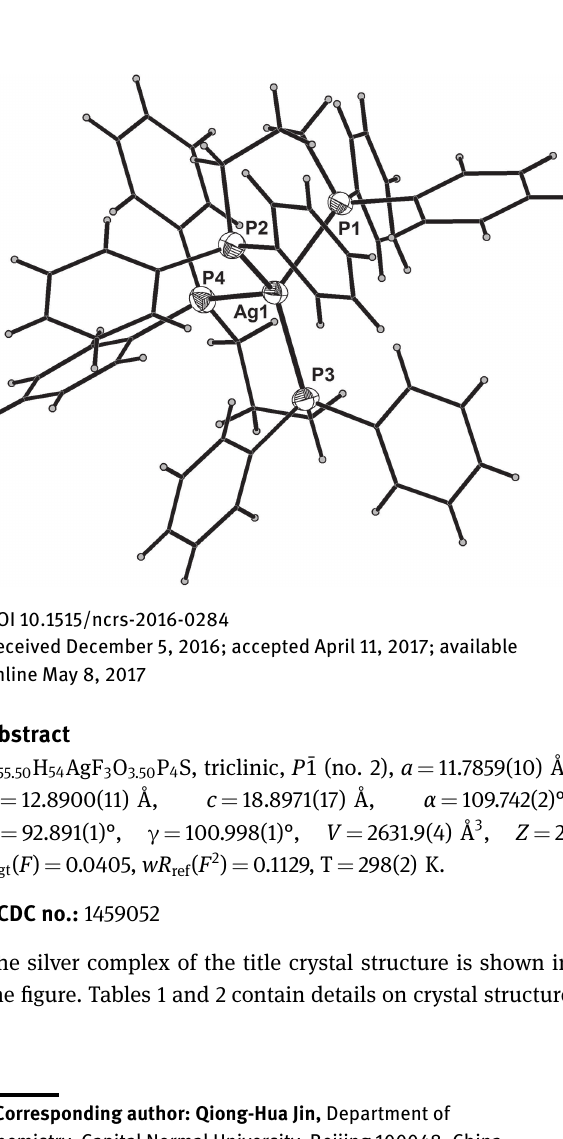
The silver complex of the title crystal structure is shown in the figure. Tables 1 and 2 contain details on crystal structure